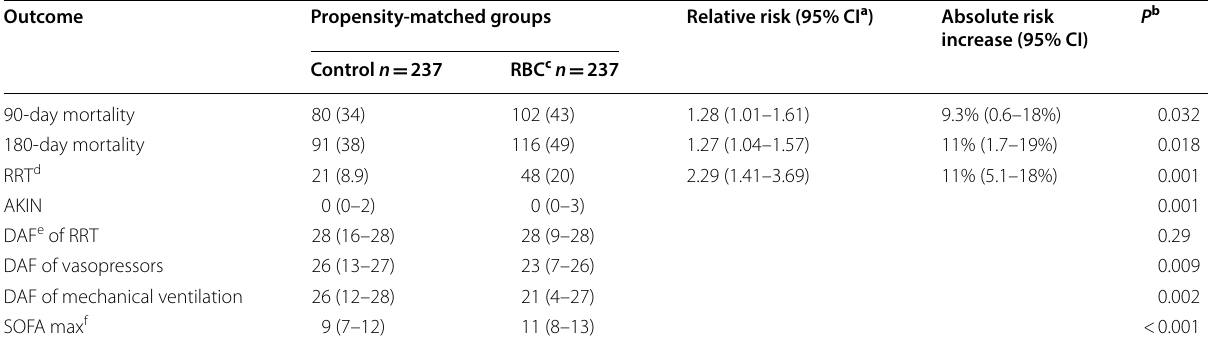
Table 3 Main outcome variables